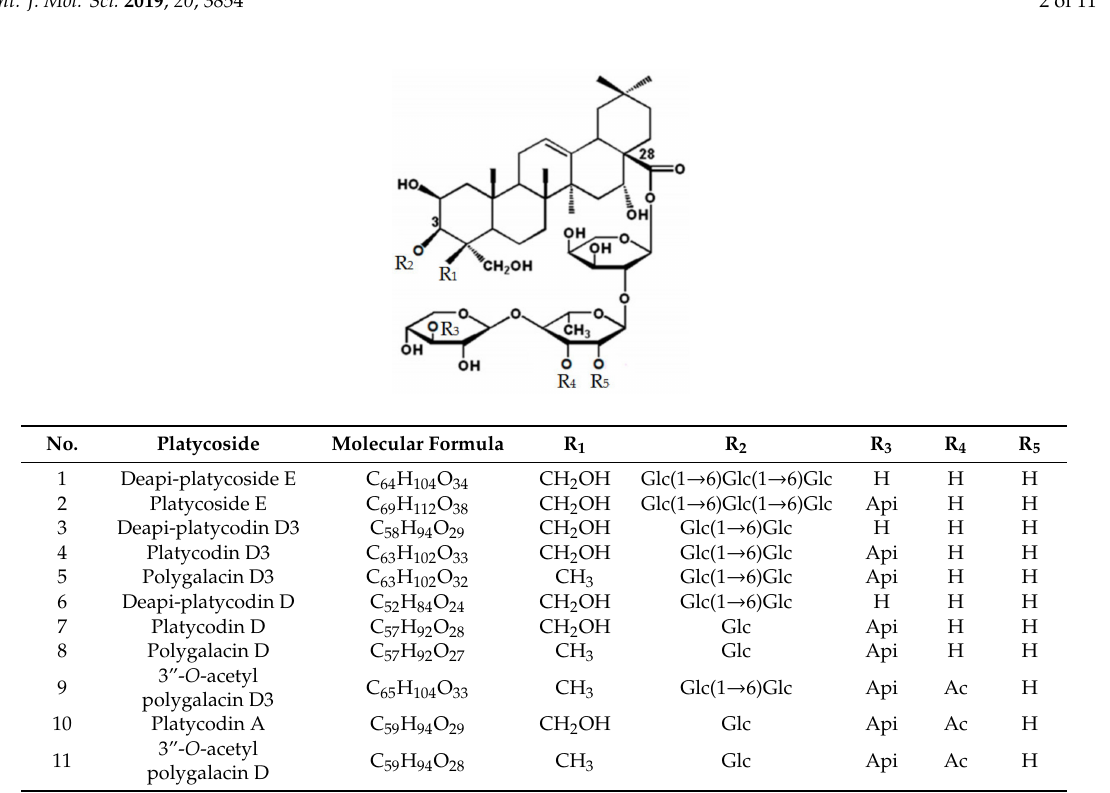
Figure 1. Chemical structures of triterpenoid platycosides in the roots of Platycodon grandiflorum and platycosides obtained after biotransformation by β -glucosidase from Caldicellulosiruptor bescii . Platycosides in the roots of P. grandiflorum are shown by numbers 1–10; the intermediate platycosides obtained during biotransformation are numbers 3 and 4; and the product platycosides obtained during biotransformation are numbers 6–8 and 11. Platycosides in the roots of P. grandiflorum contain glycosides at C-3 and C-28. The glycosides at C-3 are Glc, Glc-Glc, and Glc-Glc-Glc. The glycosides at C-28 are Ara-Rham (or Rham(Ac))-Xyl-Api). Glc, β - d -glucopyranosyl-; Ara, α - l -arabinopyranosyl-;